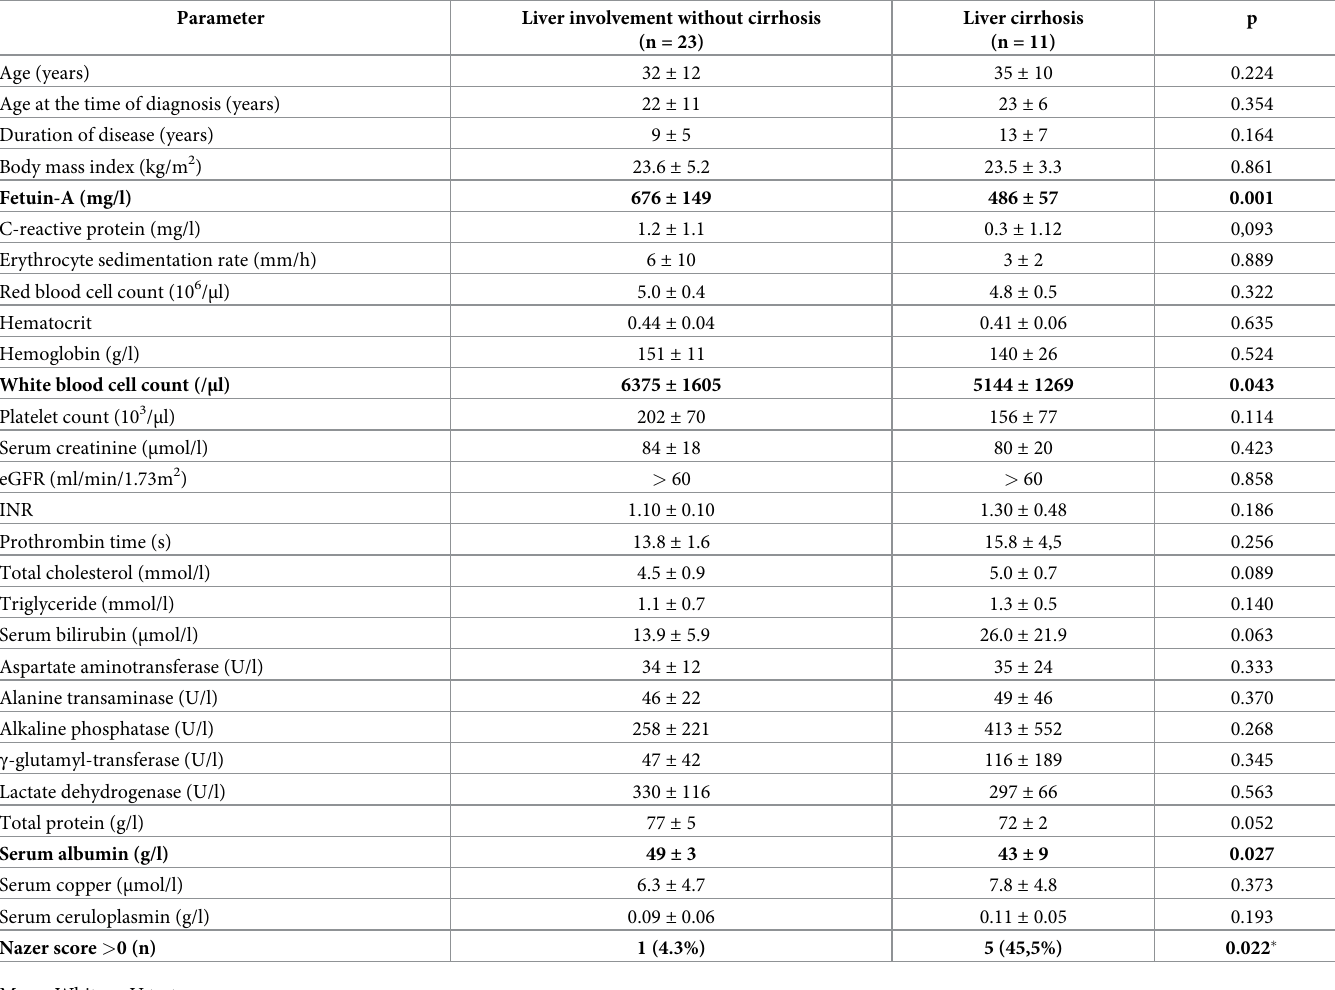
Table 1. Comparison of laboratory parameters of Wilson patients with non-cirrhotic and cirrhotic liver involvement (mean ±